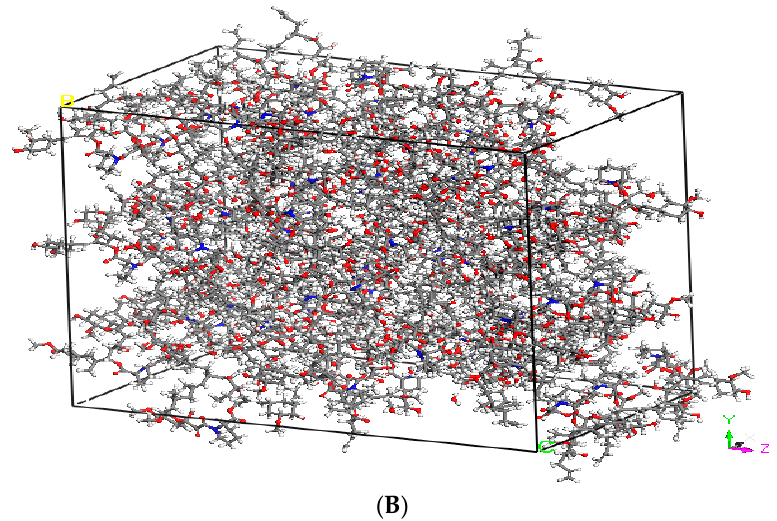
Figure 1. ( A ) Crystal structure of tacrolimus (TAC) ( B ) equilibrated amorphous cell of TAC (72 molecules).